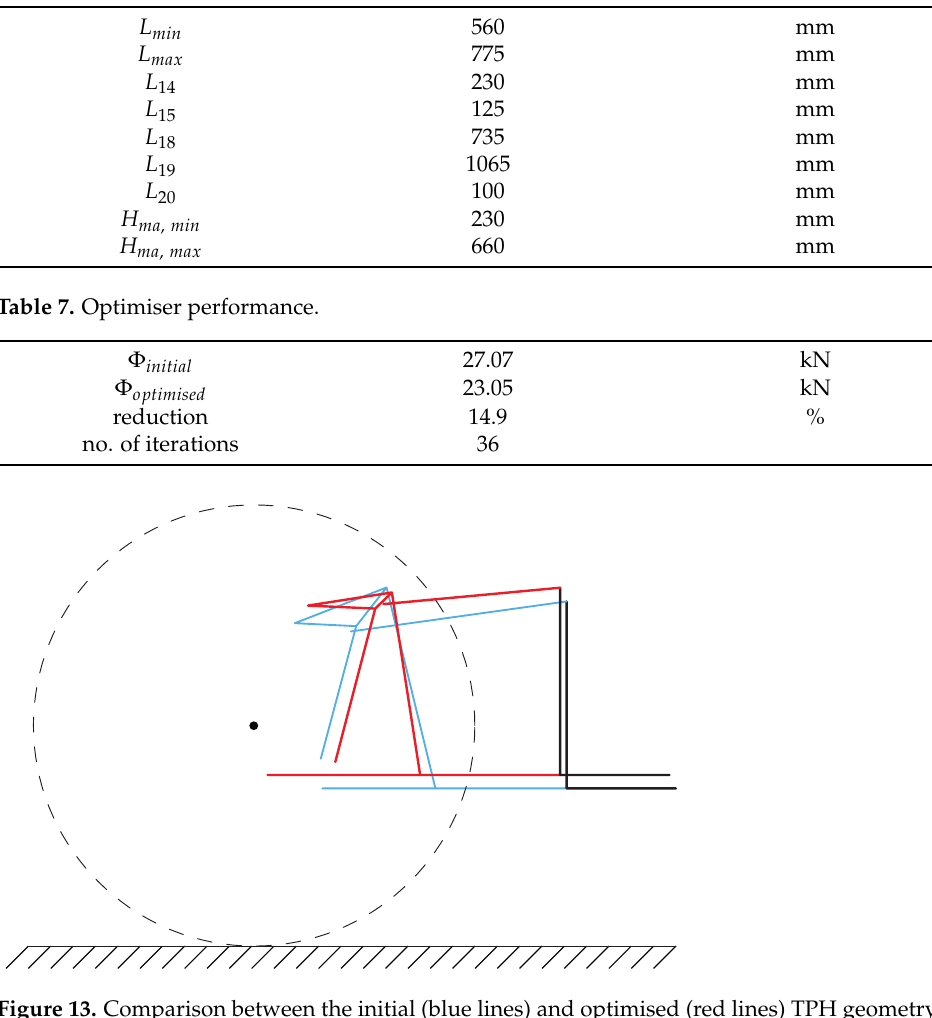
Table 6. ISO-730 functional prescriptions for a category 3 TPH (Section 2.6.1 and Table 1).